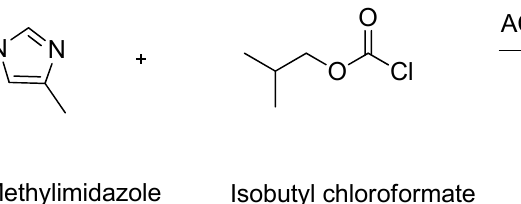
Figure 3. Derivatization reaction of 4(5)MEI with isobutyl chloroformate. Solid phase microextraction (SPME) in combination with the GC-MS analysis have also been used by Lim and Shin [40] for the extraction of 4(5)MEI from beverages. The researchers tested four fibers, polydimethylsiloxane (PDMS), polydimethylsiloxane-divinylbenzene (PDMS-DVB), polyamide (PA), carboxen-polydimethylsiloxane (CAR-PDMS). As a result, PDMS-DVB was evaluated as the most suitable.